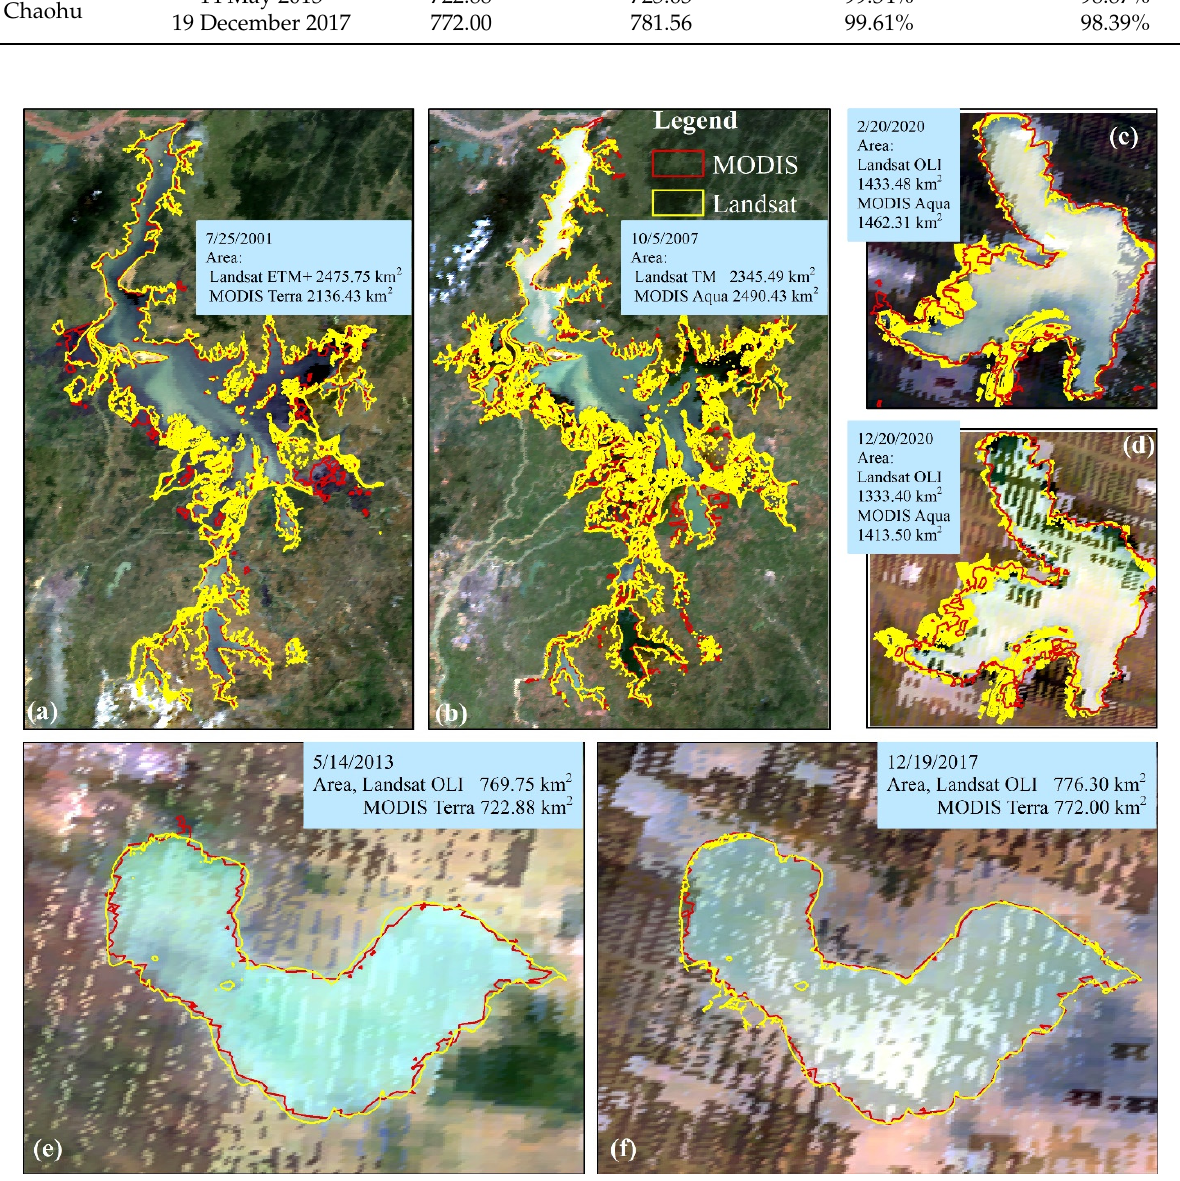
Figure 6. Comparisons between the water-land boundaries derived from Landsat and MODIS. Poyang: ( a , b ); Hongze: ( c , d ); and Chaohu: ( e , f ). Red and yellow lines represent the boundaries de- rived from MODIS and Landsat, respectively.